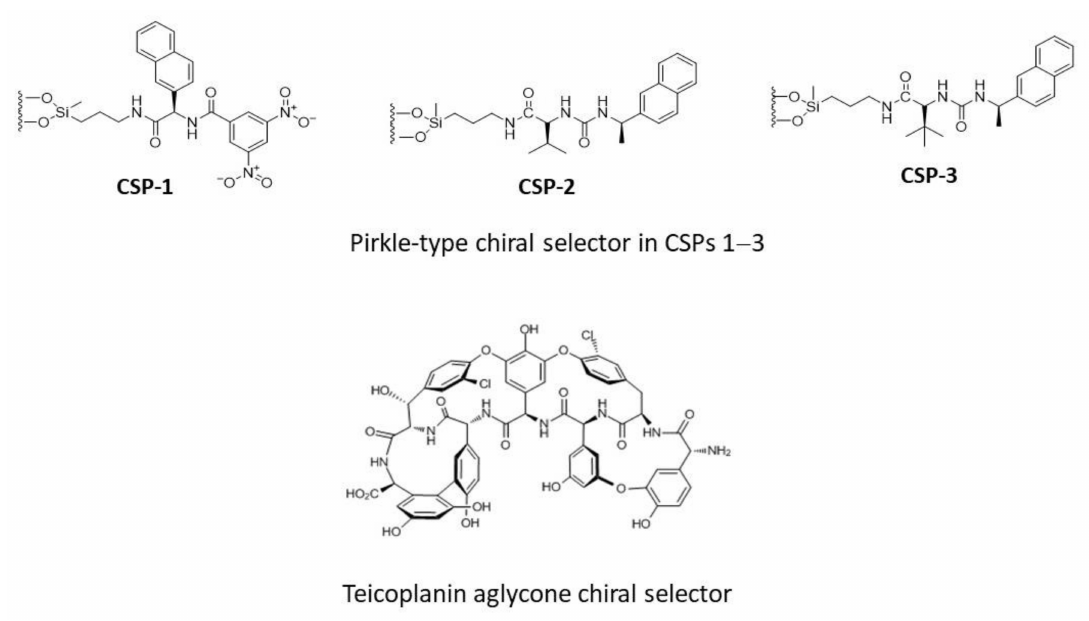
Figure 2. Chiral selectors of the CSPs investigated in this